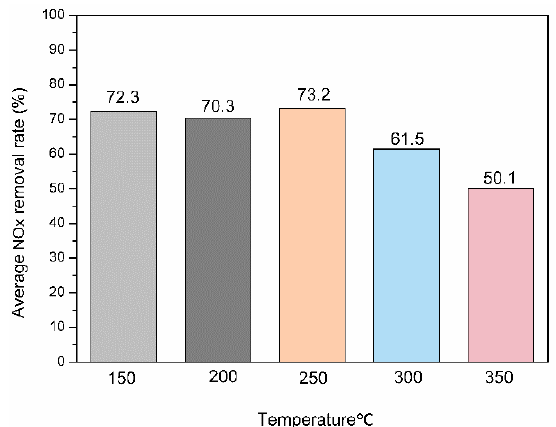
Figure 10. Average NO x removal rate of Mn15 sample at different temperatures during lean-rich cycling experiments.